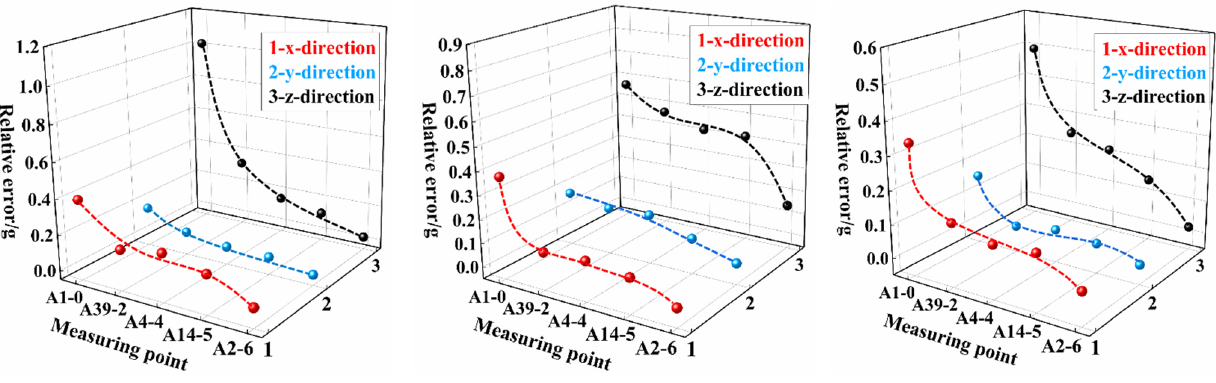
Figure 14. Relative errors of peak acceleration between the two models.